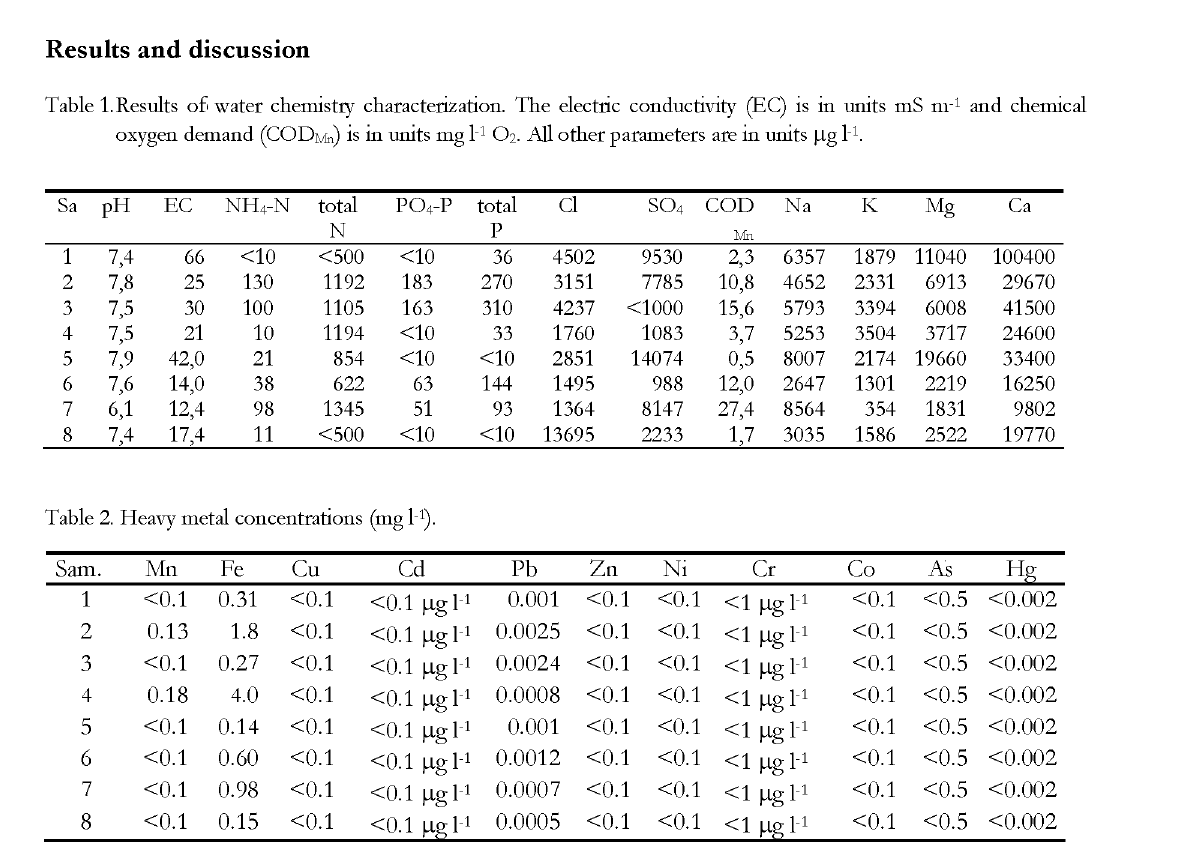
Table 2. Heavy metal concentrations (mg l -1